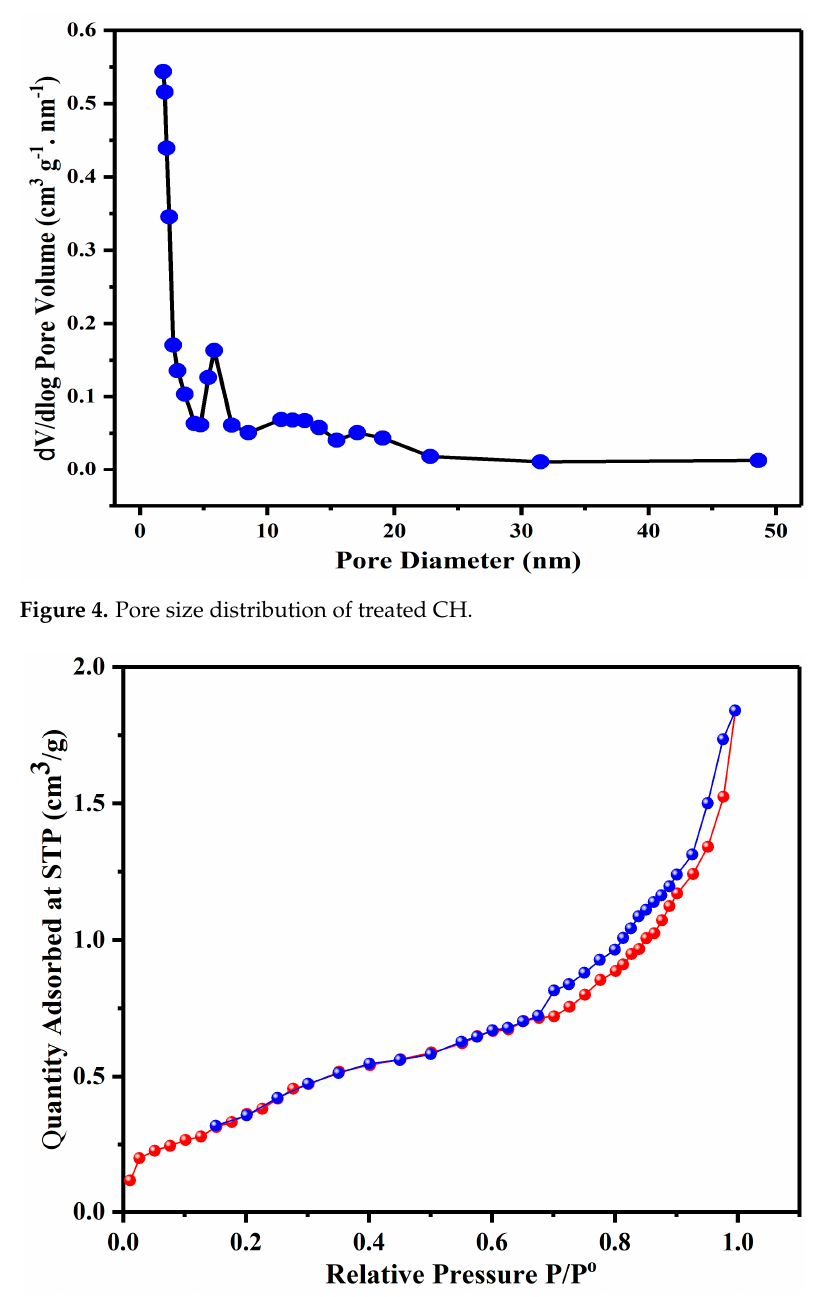
Figure 5. Nitrogen adsorption–desorption isotherm of the treated CH.